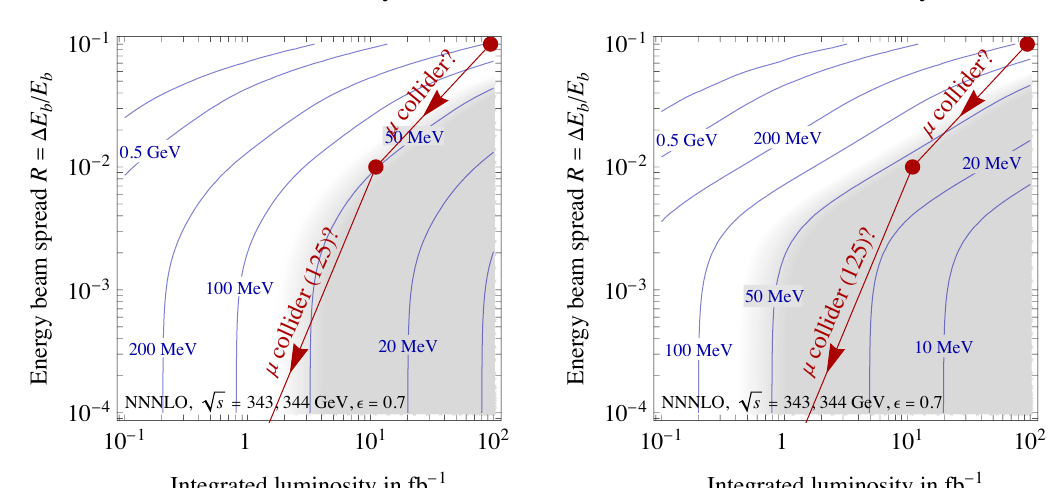
Figure 4 . Statistical uncertainty on the top mass. Initial State Radiation is neglected, as appropriate for a muon collider. The left panel assumes running at 10 values of E { 340 , 341 , . . . , 349 } GeV with L / 10 luminosity at each point. The right panel assumes running at E = { 342 , 343 } GeV with L / 2 luminosity at each point. The results are reported in the plane cm formed by the beam energy spread R , and the luminosity L . We assumed a 70% efficiency for t ¯ t reconstruction. In the shaded region the systematic uncertainty on M larger than the statistical